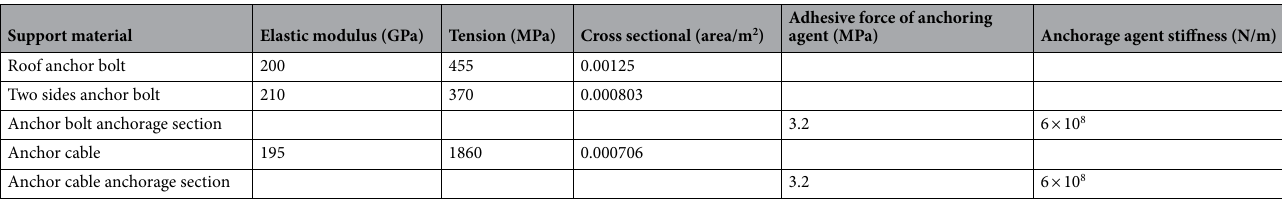
Table 4. Support material